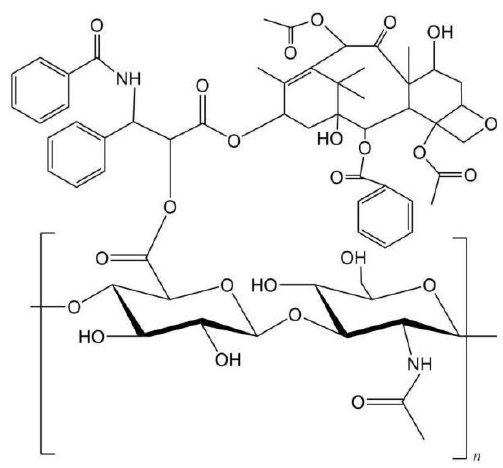
Figure 1: The molecular structure of hyaluronic acid-paclitaxel conjugates.